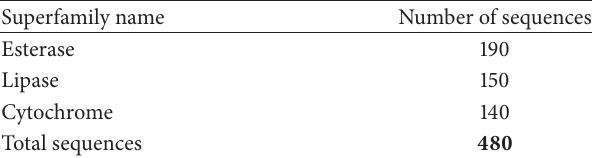
Table 6: Details of dataset 3 used in the